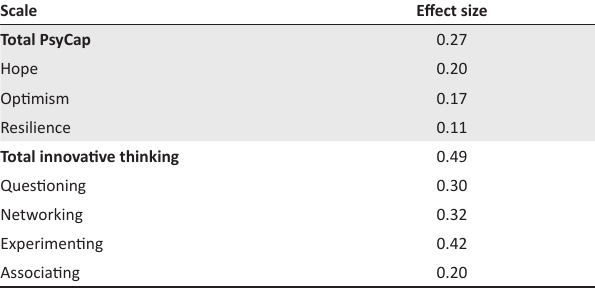
TABLE 5: Effect sizes for correlations with innovative behaviour.